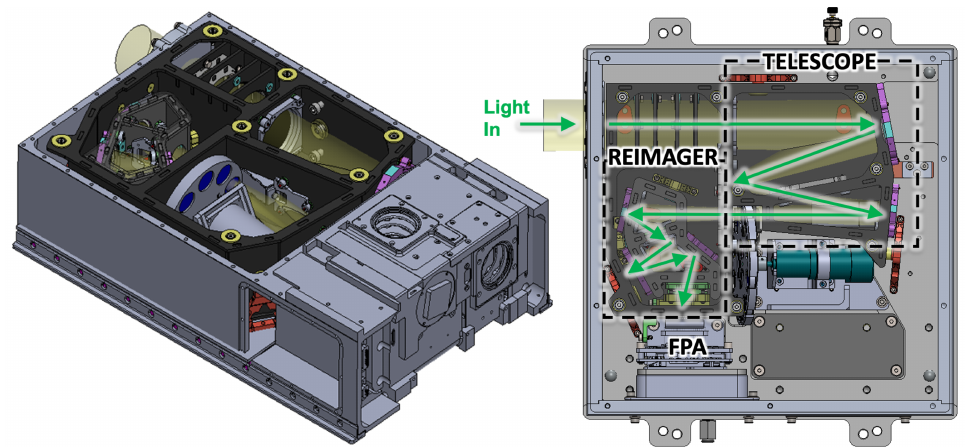
Figure 1. Illustration of the Stratospheric Aerosol and Gas Experiment IV (SAGE IV) instrument concept in a 6U CubeSat on the left and the optical train on the